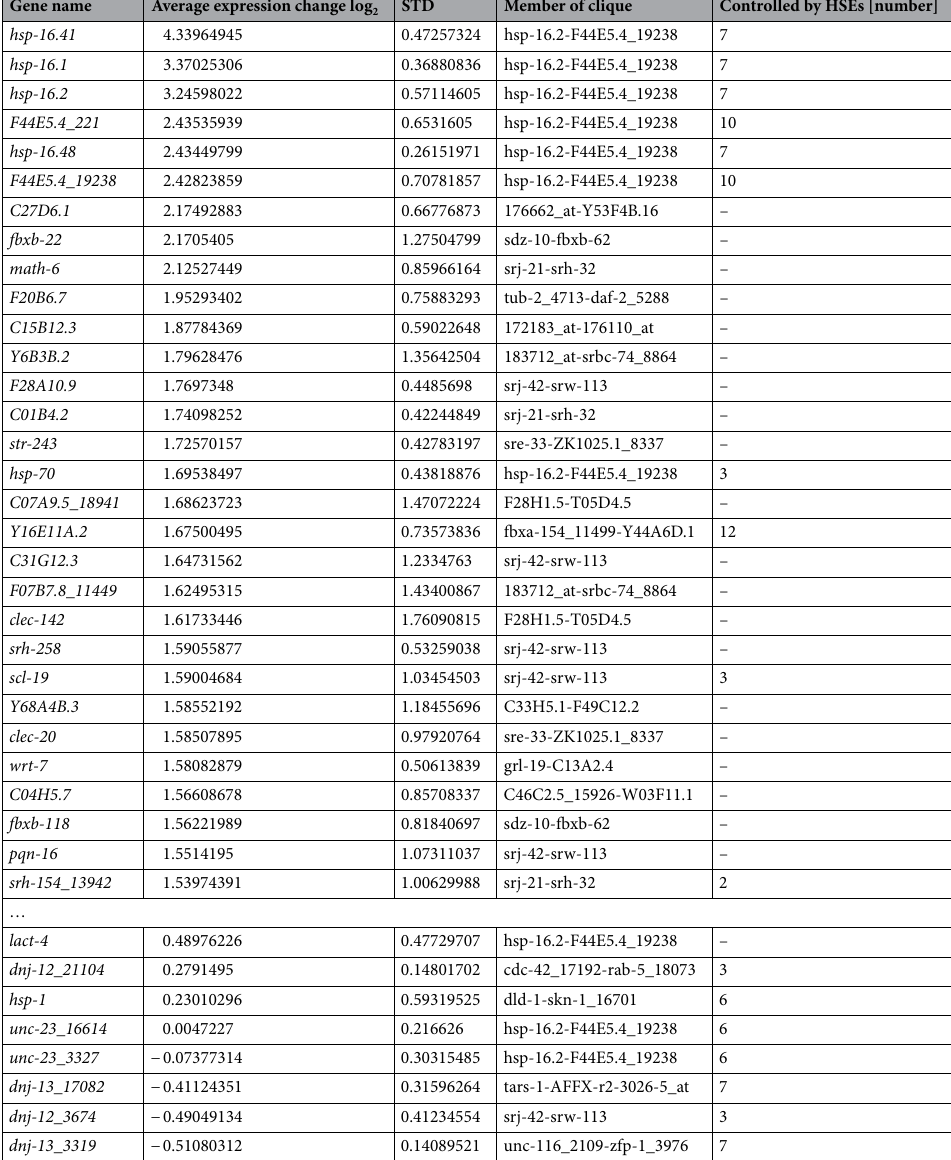
Table 2. Significantly enriched genes and their clique assignment, or number of HSEs in the promoter region of the included genes. Individual induced genes are shown and their association to cliques. Further the number of HSEs modules that can be found within 1000 bp of their upstream promoter